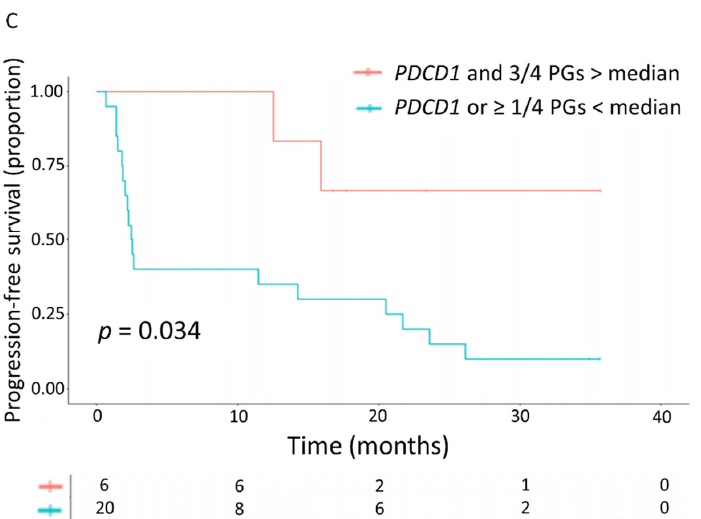
Figure 2. Kaplan-Meier curves. ( A ) Progression-free survival in patients with versus without an above-median increase in three of the four DNA replication/cell cycle genes that were upregulated in the patients with clinical benefit (PGs; DLGAP5 , TOP2A , CDCA2 , and E2F8 ). ( B ) Progression-free survival in patients with versus without an above-median increase in PDCD1 . ( C ) Progression-free survival in patients with versus without an above-median increase in three proliferation genes and PDCD1